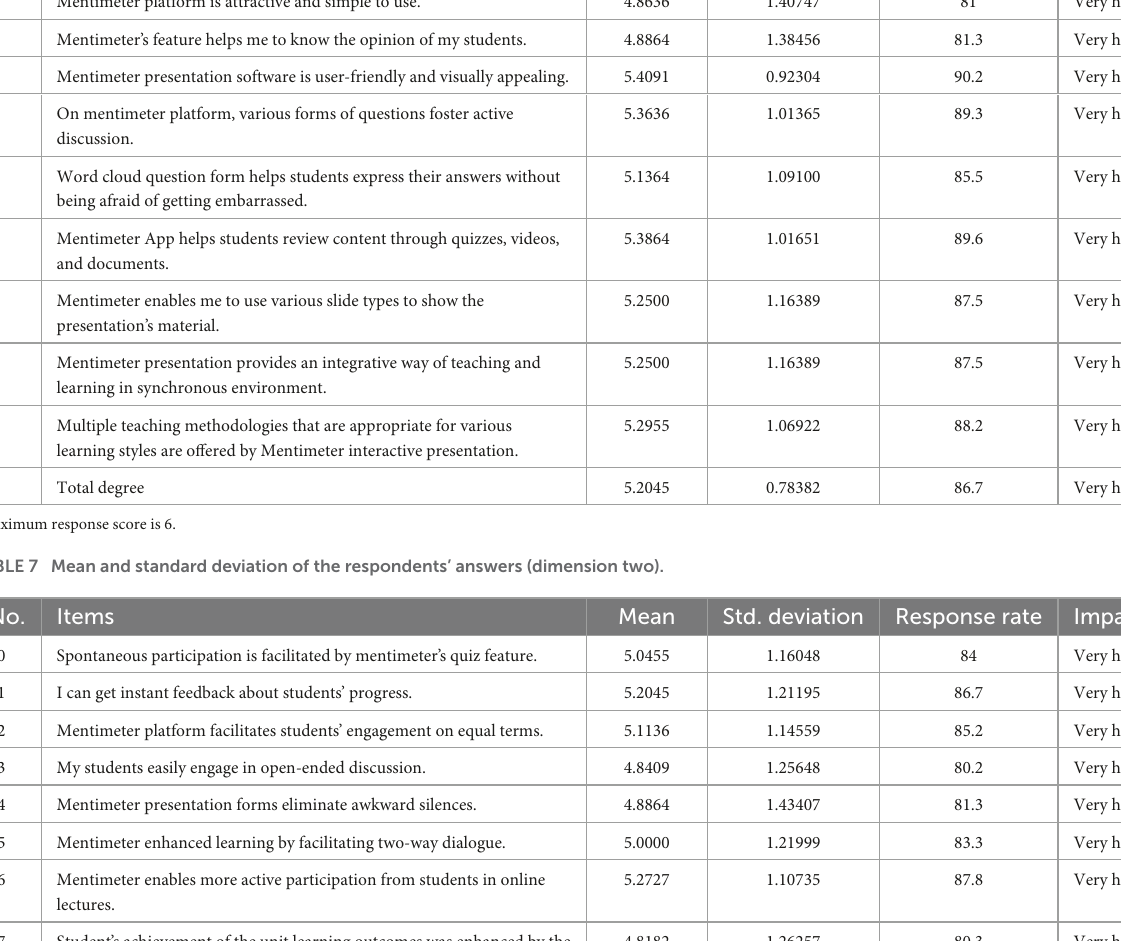
TABLE 6 Mean and standard deviation of the respondents’ answers (dimension one). No. Items Mean Std. deviation Response rate Impact degree Mentimeter platform is attractive and simple to use.